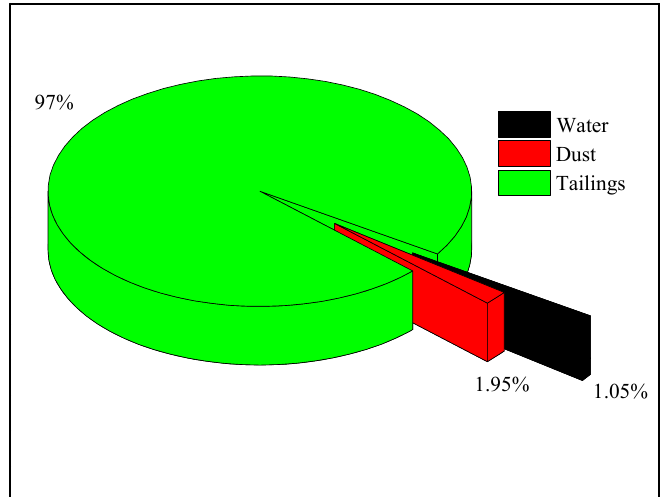
Figure 6. Distribution of PTEs between major site processing wastes.